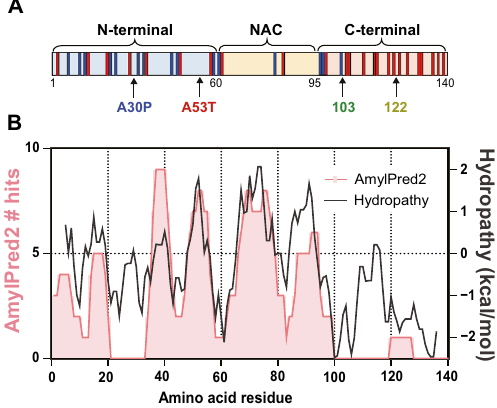
Figure 1. Schematic representation of charge distribution in three regions, aggregation propensity, and hydropathy of α-syn. A , Human α-syn consists of three regions: N-terminal (residues 1–60), non-amyloid β component (NAC, residues 61–95), and C-terminal (residues 96–140) regions. The PD-related point mutations and C-terminal truncated sites used in the present study are indicated by arrows. Red and blue lines inside protein domains represent acidic (Asp/Glu) and basic (Lys) amino acid residues, respectively. B , Aggregation propensity and hydropathy profiles of α-syn. Aggregation propensity was predicted using the consensus algorithm AmylPred2 (http:// aias. biol. uoa. gr/ AMTLP RED2/). Hydropathy plot was created using the ExPASy Protscale tool with the Kyte & Doolittle scale (http:// web. expasy. org/ prots